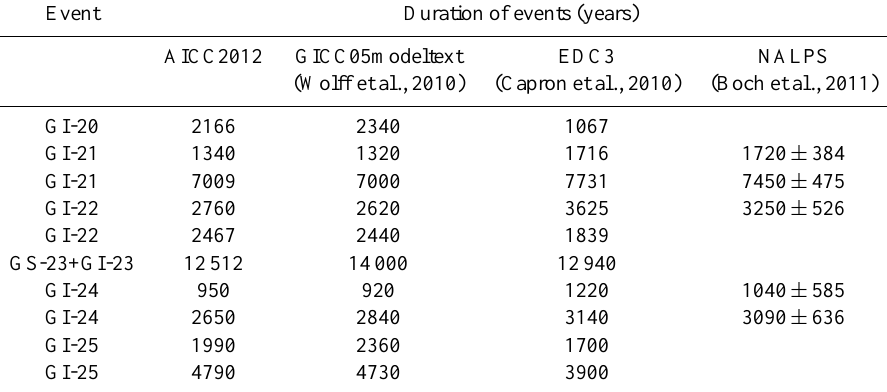
Table 1. Overview of event durations over the period 70–120 ka BP of the NGRIP δ 18 O ice as constrained on three different ice core time series: AICC2012 (this study), GICC05modelext (Wolff et al., 2010) and the EDC-3 (Capron et al., 2010), and the NALPS composite speleothem record (Boch et al., 2011). Stadial-interstadial boundaries have been defined by eye using 20yr-resolution δ 18 O data and Ca 2 + data from the NGRIP, GRIP, and GISP2 ice cores synchronized to GICC05 following the method described in Rasmussen et al. (2008). The details of this approach will be reported elsewhere (I. Seierstad, personal communication, 2012). The short events within GS-24 and GS-22 (“precursor events”) are not included in the GI and GS duration estimates, and the definition of GS-22 follows Vallelonga et al. (2012). As there is no clear evidence of GS-23 in Greenland water isotopic records we give the duration of GI-23 and GS-23 as a whole. Event Duration of events